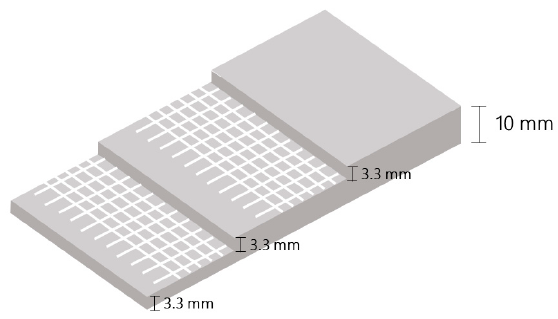
Figure 3. Stacking sequence TRC coupons.